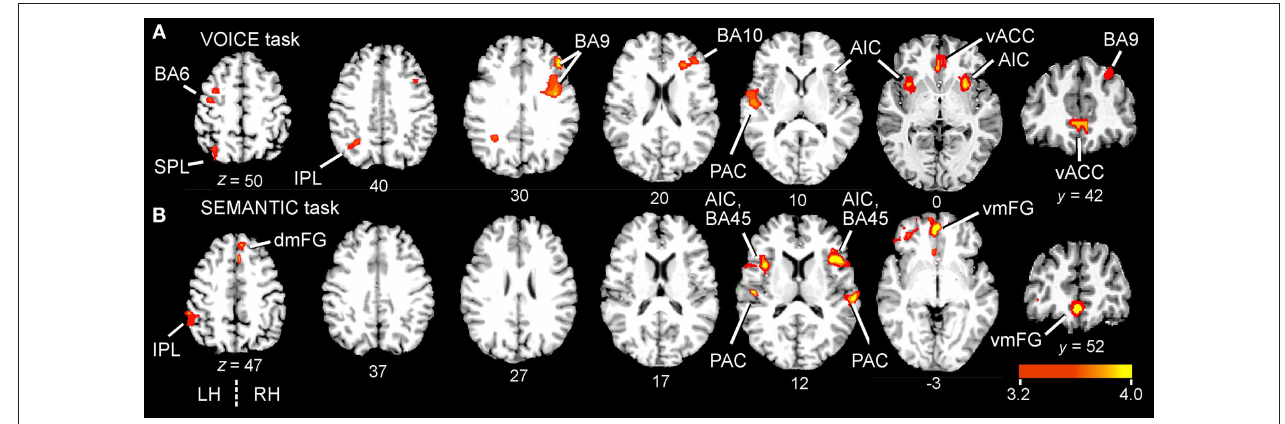
shown beneath each image. The VOICE (sensory) task (A) activated both dorsal and ventral frontal regions, while the SEMANTIC task (B) engaged mainly ventral areas. Complete lists of activated clusters are given in Table 1 . AIC, anterior insular cortex; BA, Brodmann area; dmFG, dorsomedial frontal gyrus; IPL, inferior parietal lobule; PAC, primary auditory cortex; SPL, superior parietal lobule; vACC, ventral anterior cingulate cortex; vmFG, ventromedial frontal gyrus.